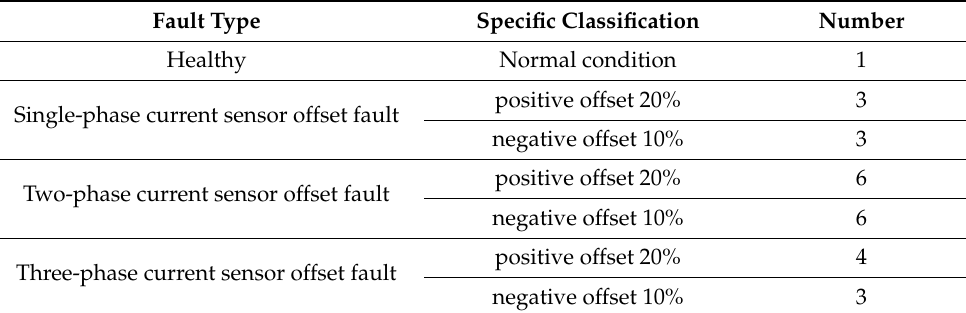
Table 2. Three-phase current sensor fault types.